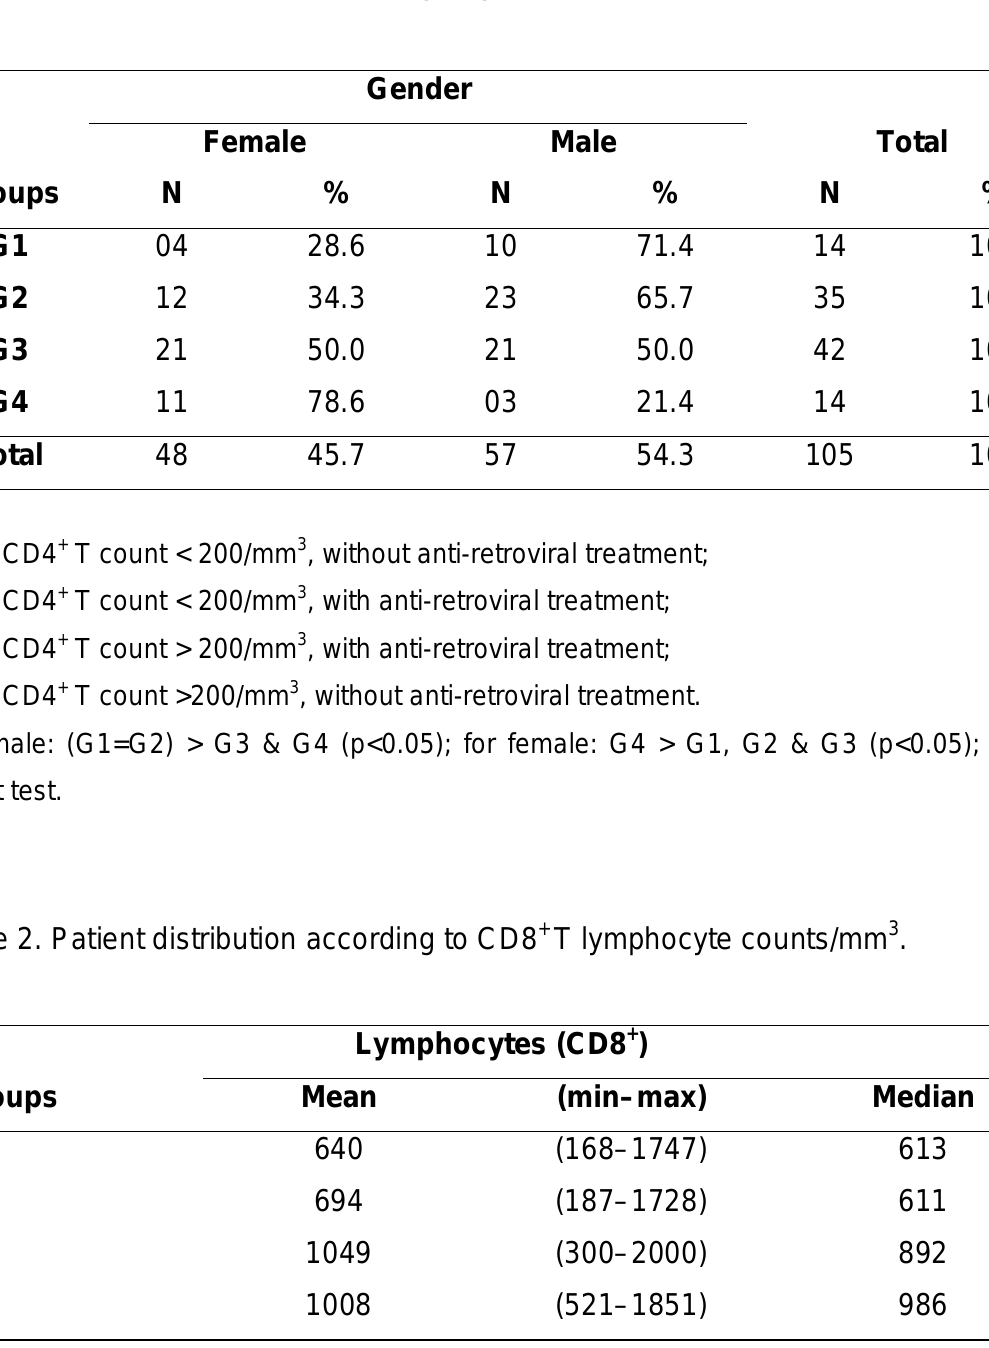
Table 1. Patient distribution according to gender.